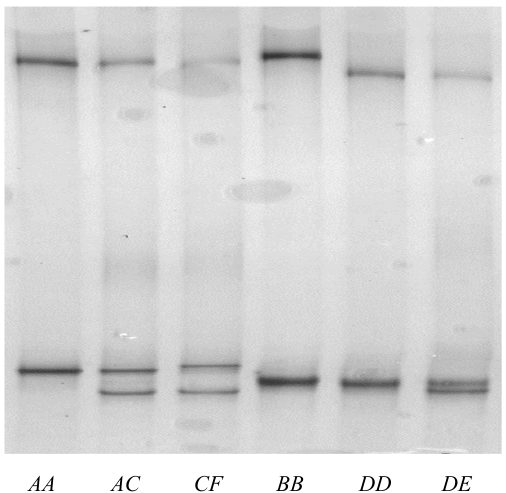
Figure 3. PCR-single-stranded conformational polymorphism of the ovine KAP28-1 gene. Five unique banding patterns corresponding to five variant sequences ( A – E ) are shown in either homozygous or heterozygous forms.